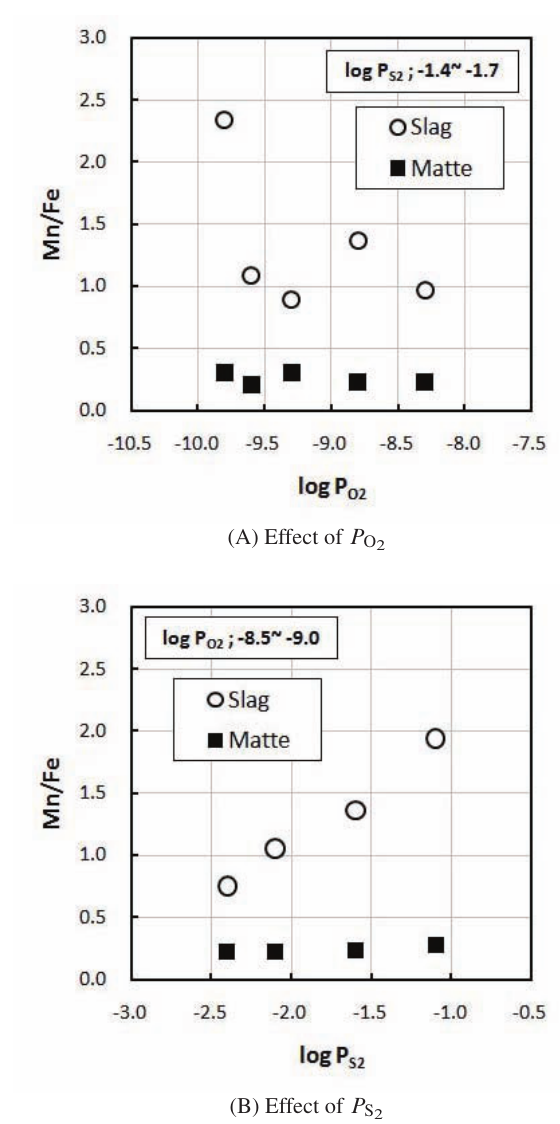
or P S on the content ratio of 2 2